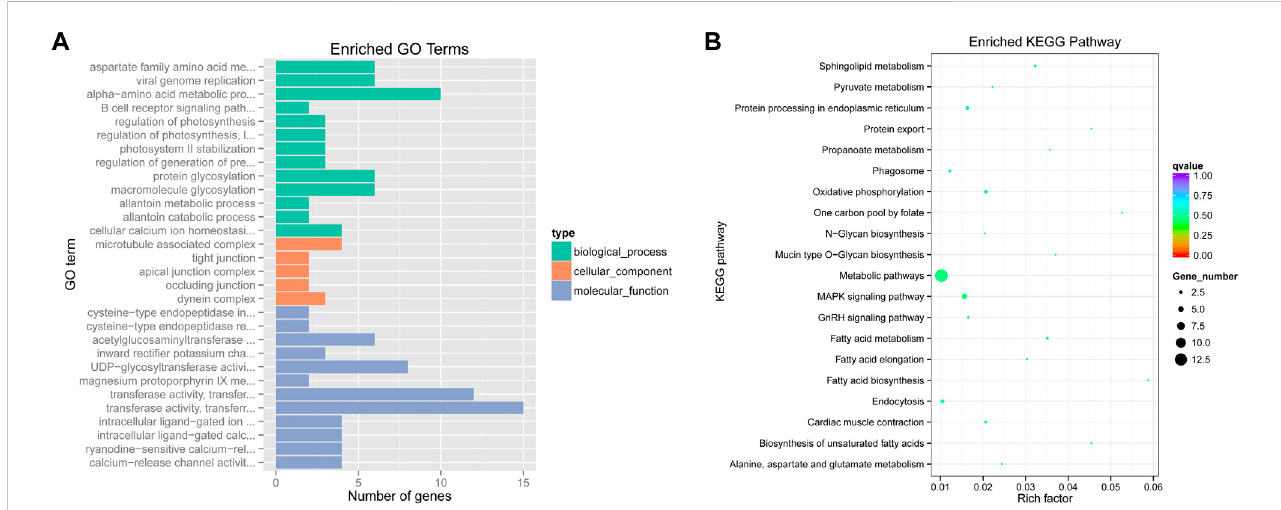
FIGURE 4 Functional enrichment analyses of potential selected genes. (A) . GO enrichment terms; (B) . KEGG enrichment pathways.